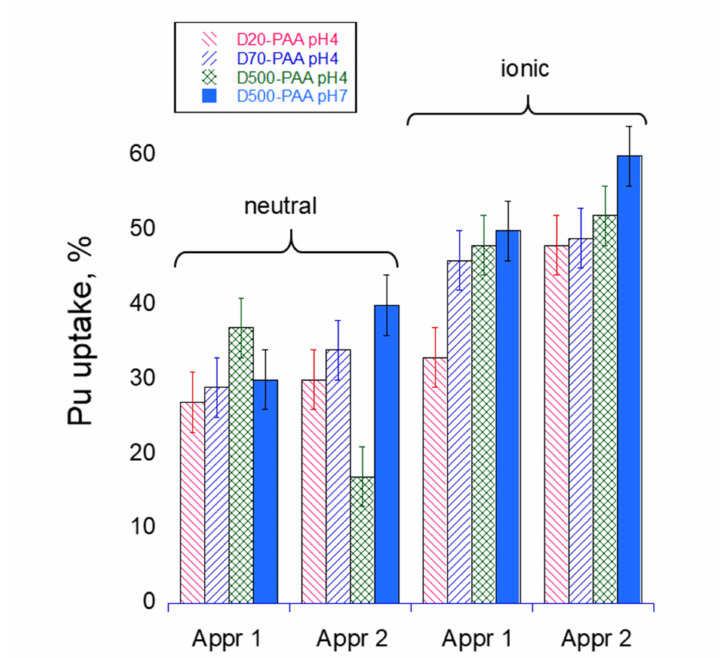
Figure 5. Plutonium-242 uptake (%) from the water solution 33 ppb by the star-like polyacrylamides in two different approaches. In each case, 1 mg of polymer in DI water was either mixed with Pu solution (Approach 1) and then filtered out on PVDF A6 UF membrane or deposited on the membrane first, and then the uranium solution was passed through it (Approach 2). The Pu solution was kept on top of the membrane for 15 min before the application of the external pressure in each case. Around 20% Pu uptake was observed for unmodified A6 membrane under the same conditions.